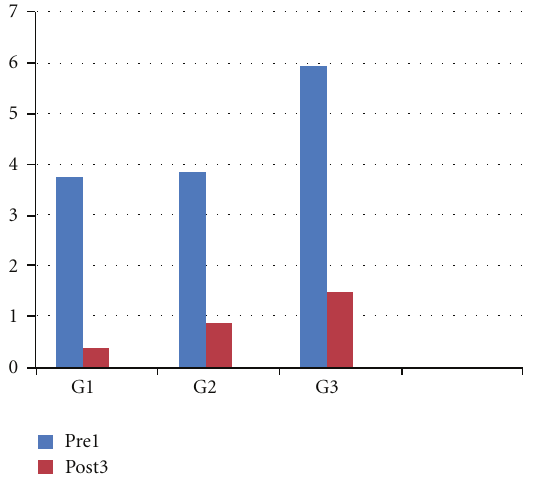
Figure 7: Illustrative representation of the improvement to the air stimuli from the first treatment to the third